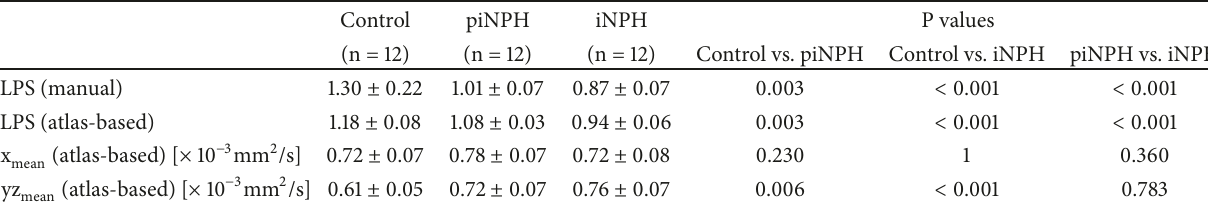
Table 4: ALPS index, Dx mean and Dyz mean of the control, piNPH, and iNPH groups. Control piNPH iNPH P values